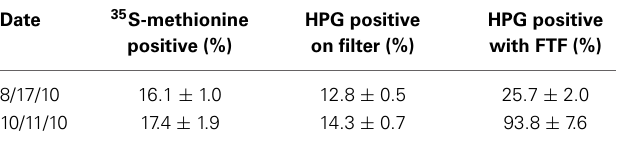
Table 1 | Percent labeling in two natural assemblages as quantified via three methods: (i) 35 S-methionine microautoradiography, (ii) HPG on polycarbonate filters, and (iii) HPG with the freeze-transfer-freeze method.